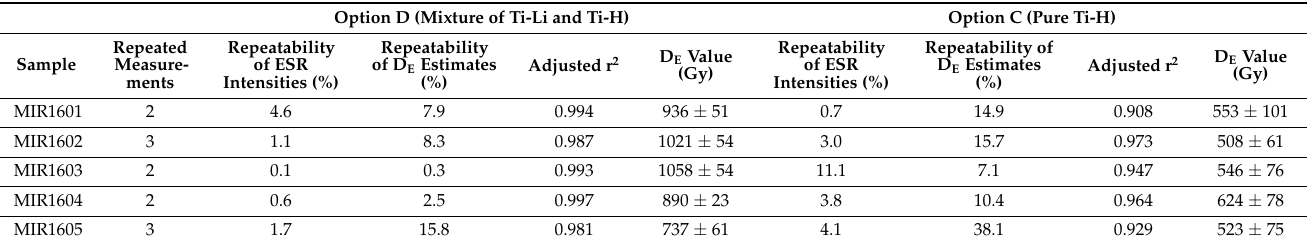
Table 3. ESR data derived from measurement of Ti centers. Repeatability of ESR intensities is assessed through variability (1 relative standard deviation) of mean ESR intensities obtained after each day of measurement. Similarly, repeatability of D E values corresponds to variability (1 relative standard deviation) of D E values calculated for each day of measurement. Option D (Mixture of Ti-Li and Ti-H) Option C (Pure